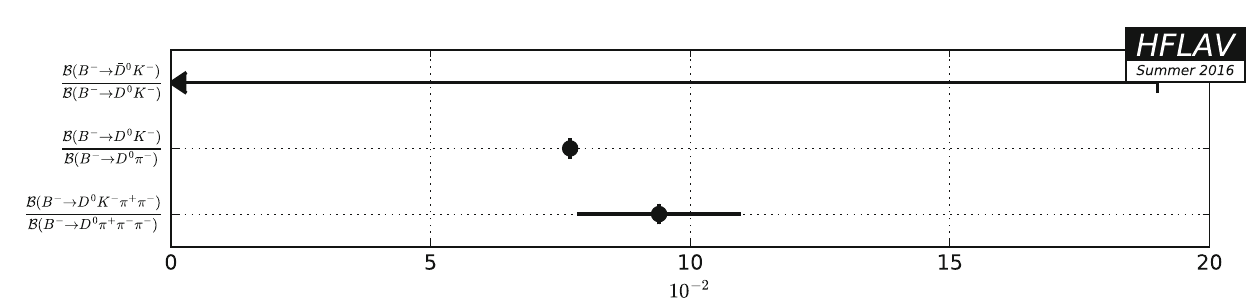
Fig. 109 Summary of the averages from Table 138